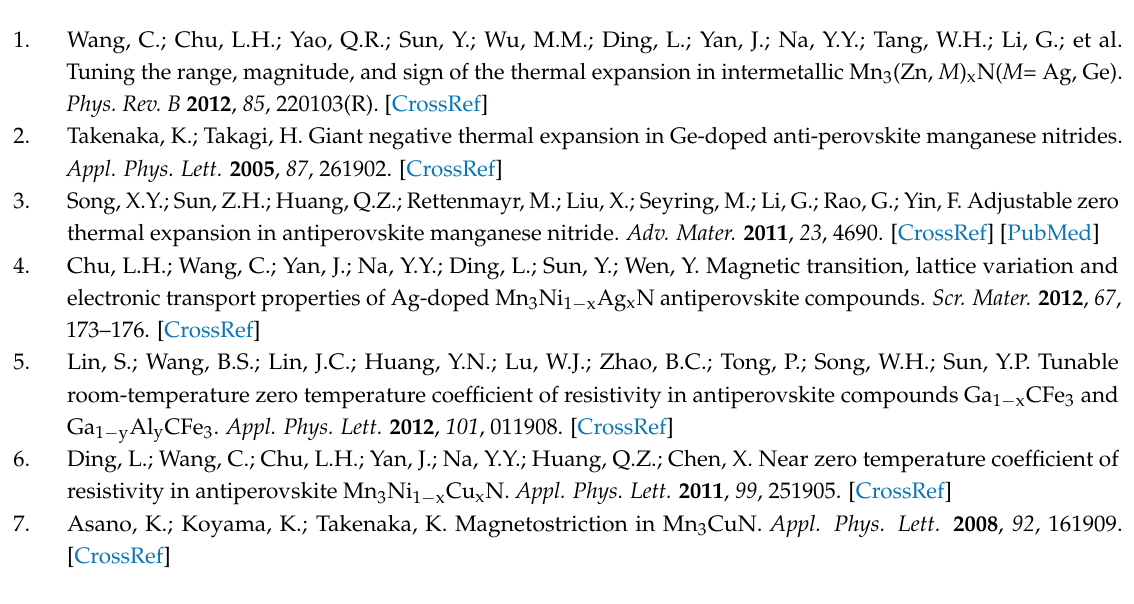
Figure S1: Magnetoresistance curves measured at 5 K for samples with x = 0.4 and 0.7. No magnetoresistance phenomenon was